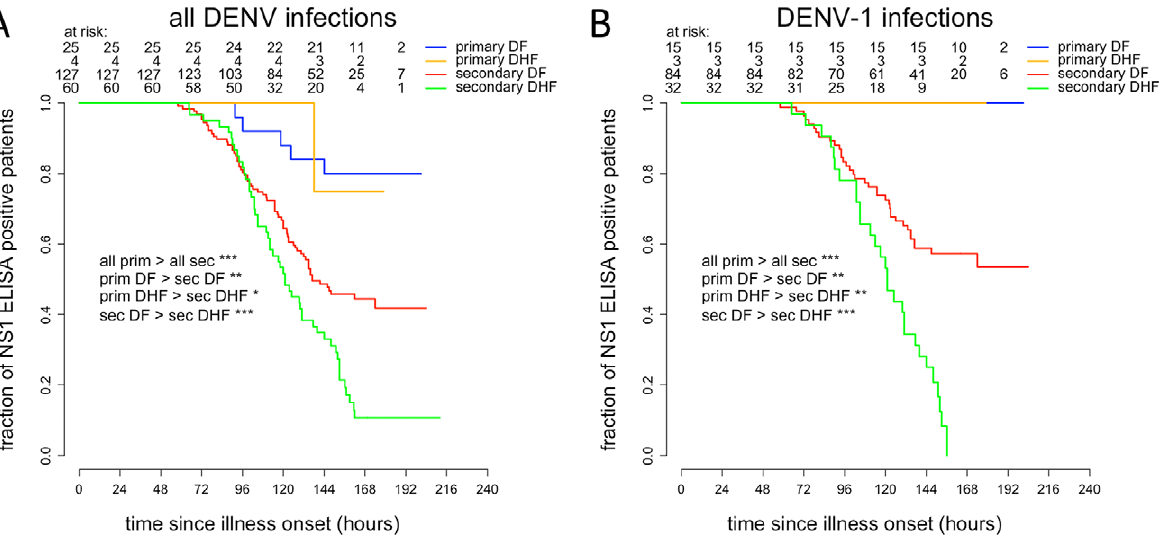
Figure 4. Time to resolution of NS1 antigenemia. Kaplan-Meyer survival analysis of time to resolution of NS1 antigenemia in all viremic A ) or DENV-1 only B ) patients. Two patients NS1 negative at enrolment were later positive and for the purposes of analysis were considered positive at the time of enrolment.